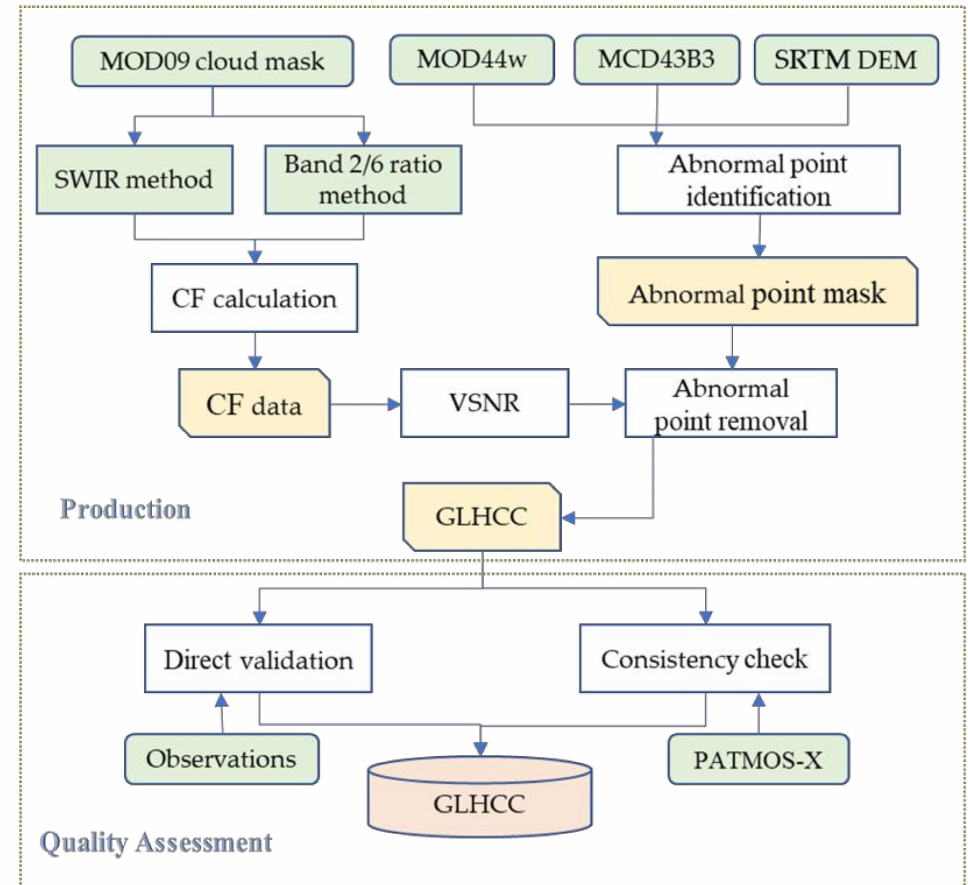
Figure 1. Flowchart for production and quality assessment of the GLHCC